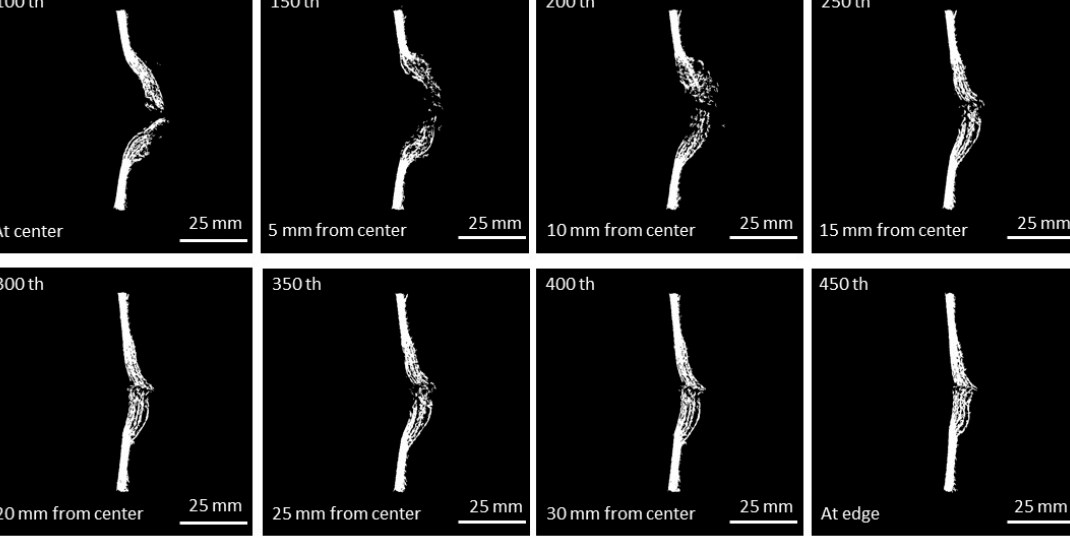
Figure 10. Basalt fiber composite after impact. µCT slices of damage from the center towards the edge. The fiber damage was investigated at the center and from each set of pictures, one picture was chosen at a distance of 5 mm towards the edge of the composite.